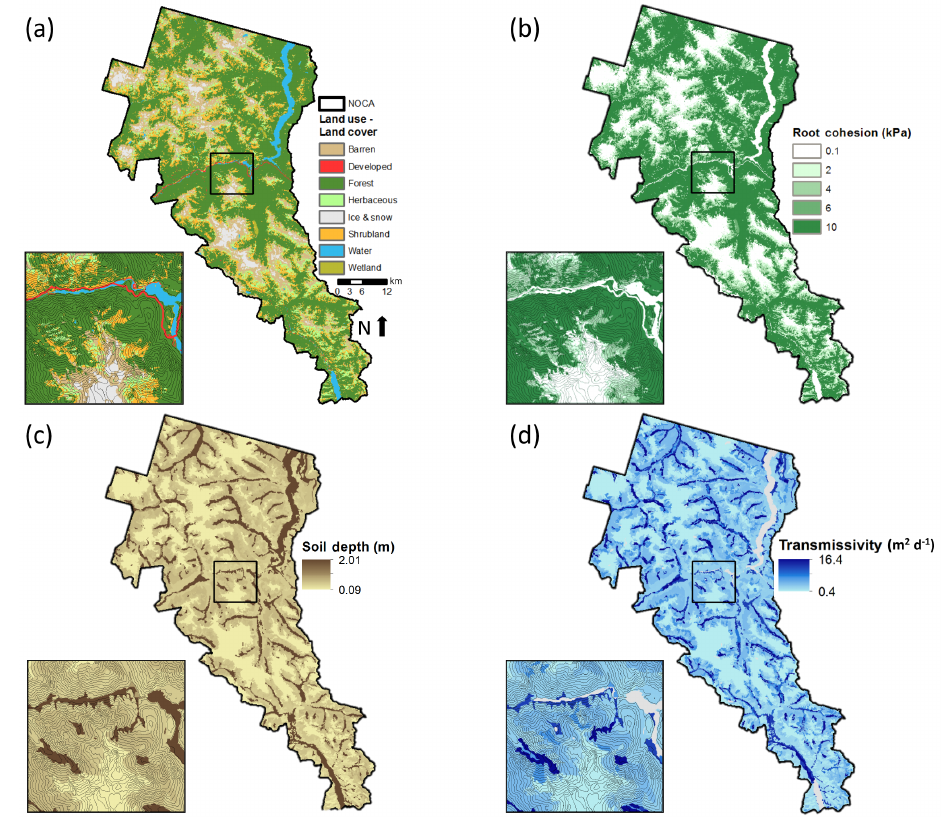
Figure 4. NOCA maps for (a) LULC classified from USGS (2014b), (b) root cohesion based on LULC, (c) soil depth from SSURGO, and (d) transmissivity based on SSURGO soil depth. Mapped values in (b) through (d) represent the mode values used in triangular distribution for Monte Carlo simulations. Inserts show zoomed-in area with 100m